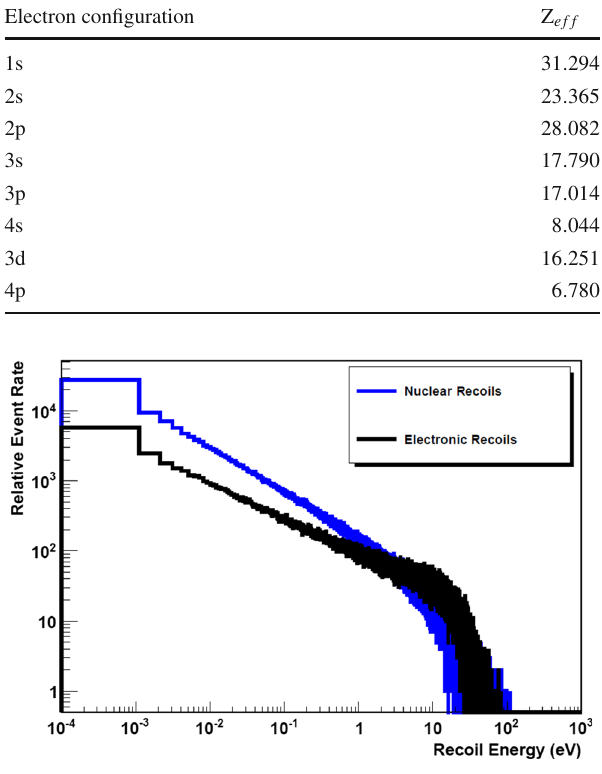
Fig. 1 The relative event rate as a function of recoil energy for DM with masses between 0.1 MeV/c 2 to 1 GeV/c